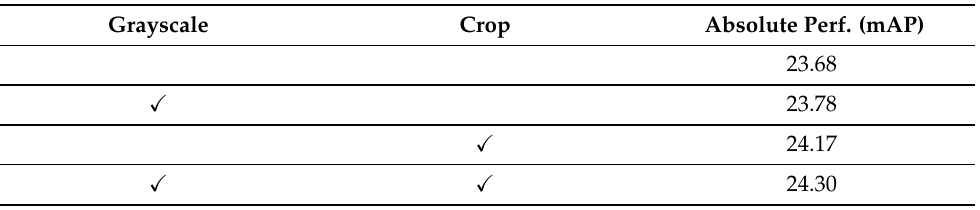
Table 5. Effect of preprocessing test images on absolute performance, with GeM trained on Google-